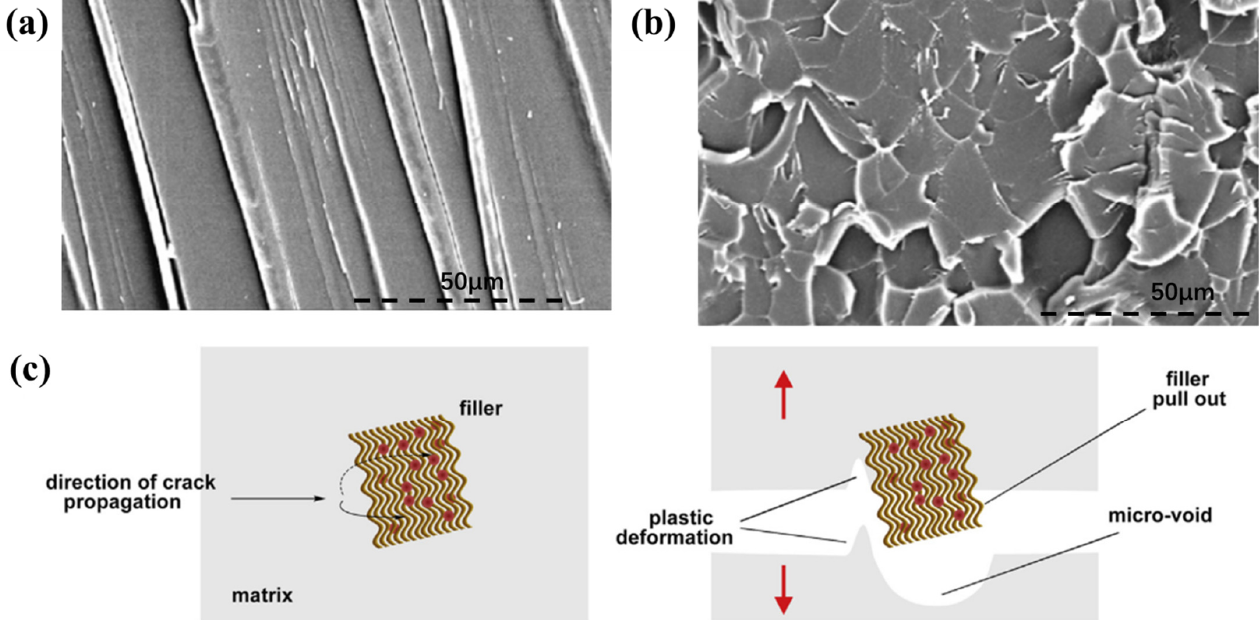
Figure 5. ( a , b ) SEM images of the impact fracture surface at 77 K of pure epoxy and graphene/epoxy composites containing 0.1 wt% graphene. Reused with permission from Ref. [40]. Copyright 2012 Elsevier. ( c ) Schematic of the fracture mechanism of graphene/epoxy composites. Reused with permission from Ref. [41]. Copyright 2017 Elsevier.